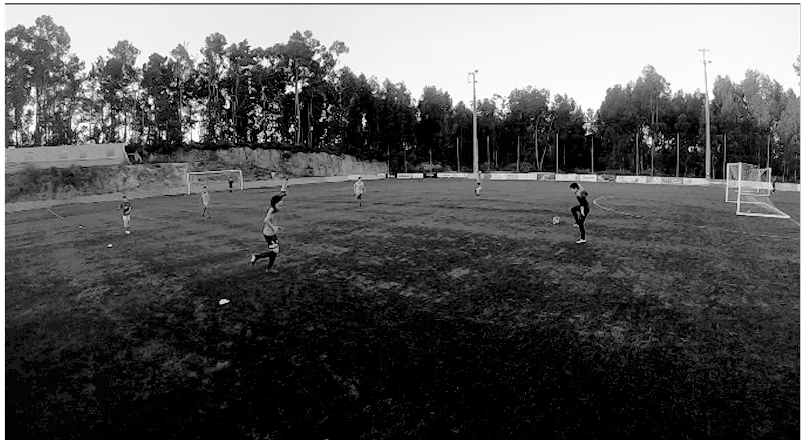
Figure 1. Four minutes of a